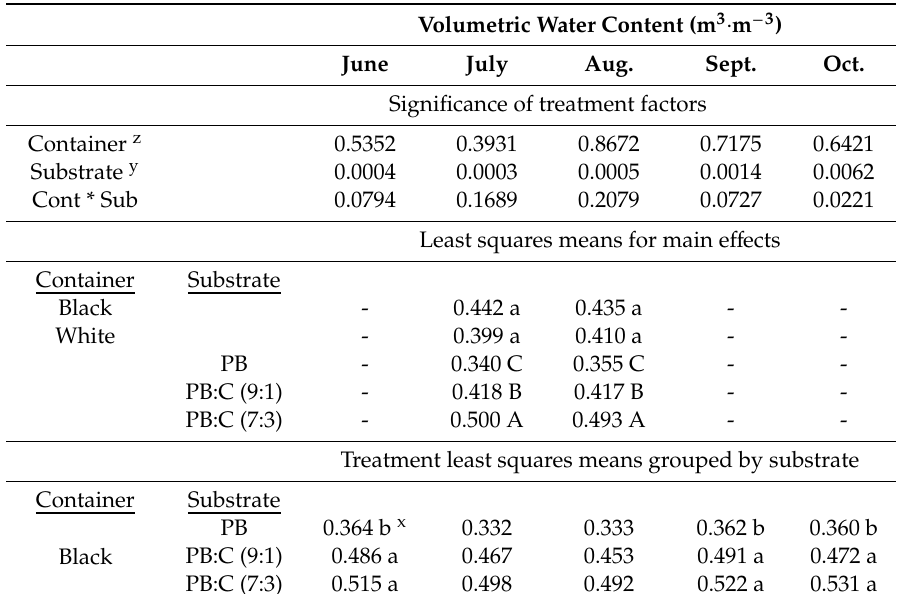
Table 6. Average daytime volumetric water content ( n = 3) over a four month period for “Green Giant” arborvitae grown in di ff erent types of containers and substrates in